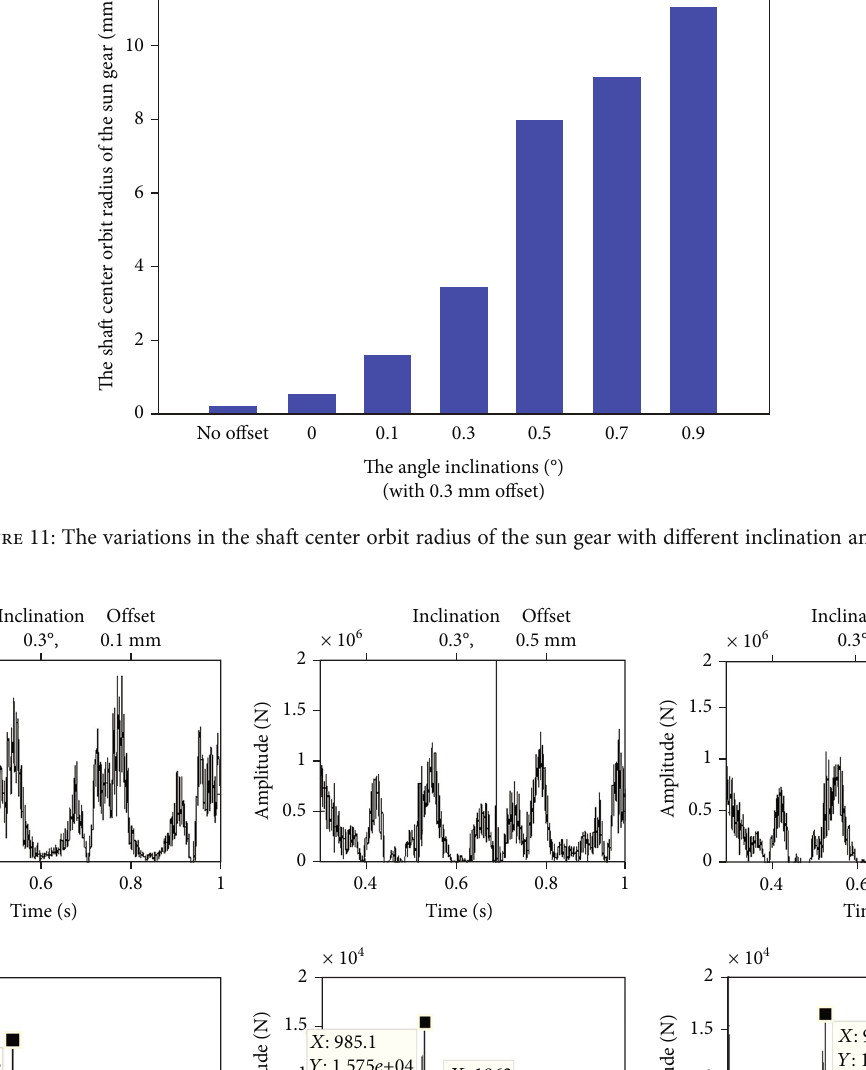
domain diagram and frequency spectrum diagram of the meshing force between the sun gear and the planetary gear at di ff erent angle inclination positions are shown in Figure 8. The variations in the average meshing force of the gears with di ff erent inclination angles are shown in Figure 9. The shaft center orbit of the sun gear is shown in Figure 10, and the variations of the shaft center orbit radius of the sun gear with the di ff erent inclination angles are detailed in Figure 11.